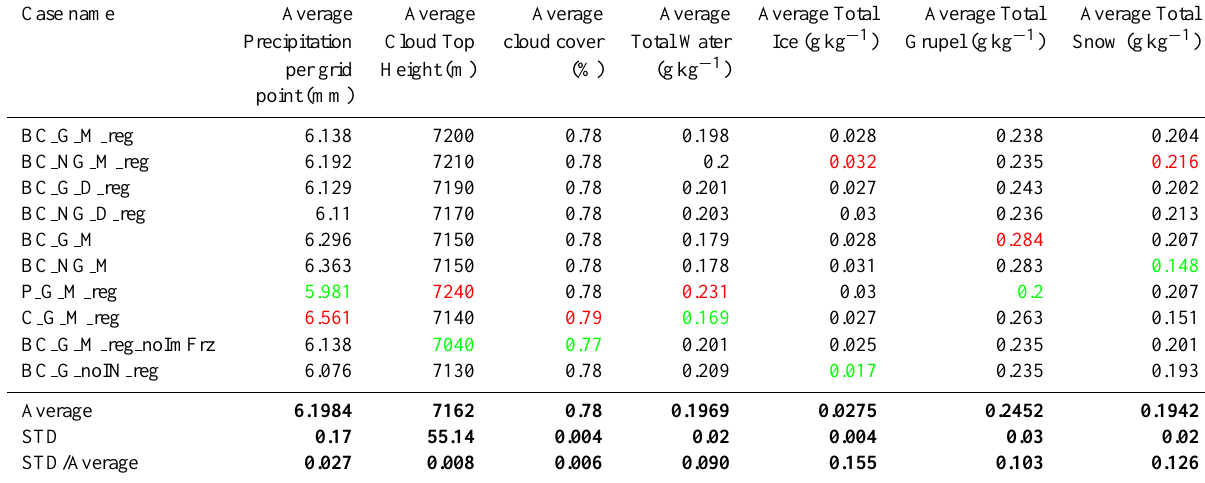
Table 2. Averages of different cloud characteristics calculated from the simulations. Numbers in green and red are low and high values of the properties,